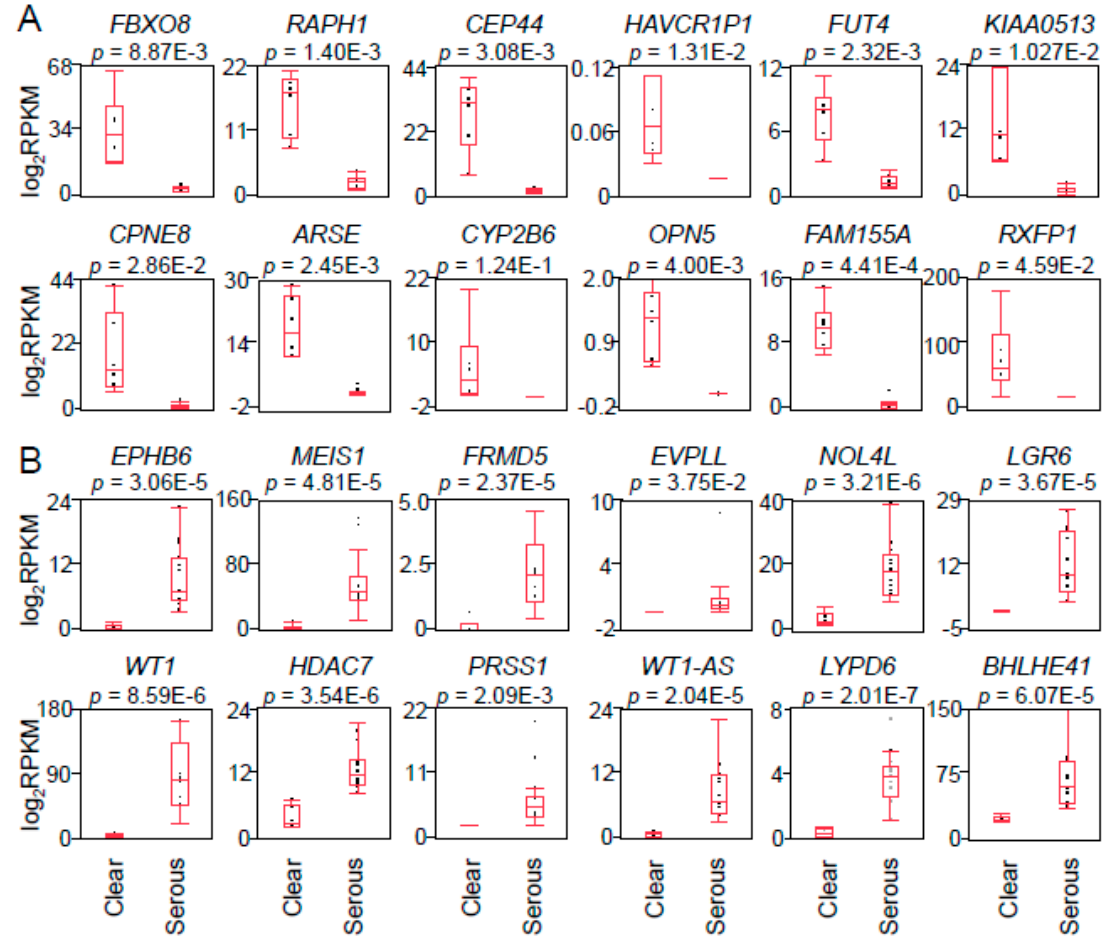
Figure 2. Expression levels of genes contributing to the first principal component of PCA in CCC and HGSC. ( A ) Expression levels (log2RPKM) of the top 12 genes contributing to PC1 negative in Figure 1E were collected from RNA-sequencing data. The box plot was created by the statistical analysis software JMP. Higher expression levels were shown in CCC compared with HGSC. ( B ) Expression levels (log2RPKM) of the top 12 genes contributing to PC1 positive in Figure 1E were collected from RNA-sequencing data. Higher expression levels were shown in HGSC compared with CCC. Results are shown as means ± SD. Statistical analysis was performed using Student’s t test followed by FDR (5%) analysis.